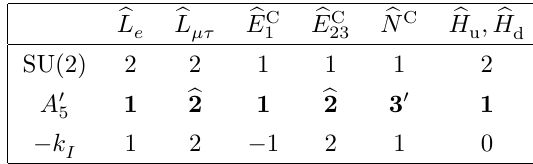
Table 1 . The charge assignment of the chiral superfields under the SU(2) the modular A 0 symmetry in our model, with the corresponding weights listed in the last 5